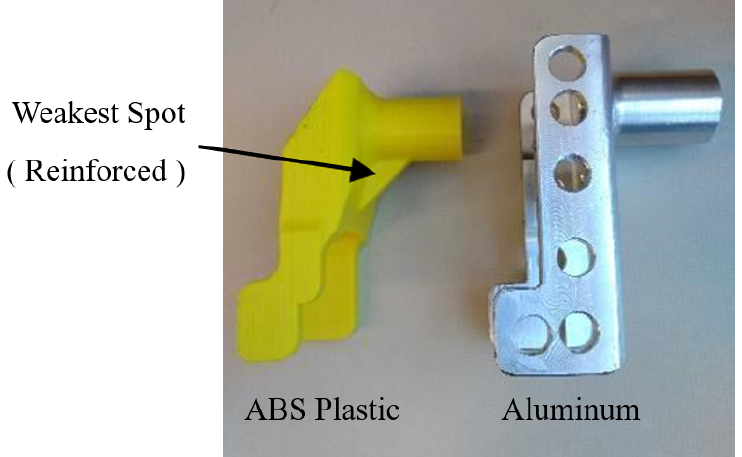
Figure 5. Two gasoline engine mount designs. The mount made of ABS plastic was lighter in weight but weaker, so was reinforced. The mount made of ABS plastic was implemented onto the